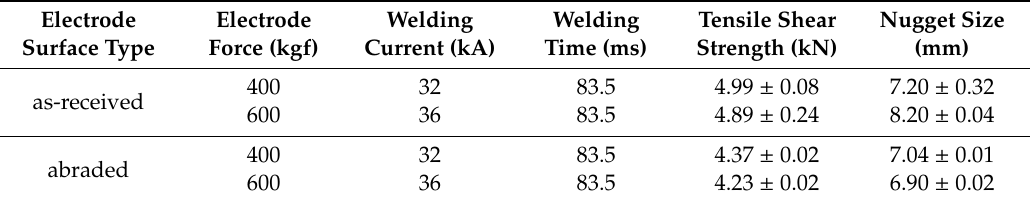
Table 3. Tensile shear strength and nugget size of welds produced using electrodes with di ff erent surface roughness and at di ff erent electrode